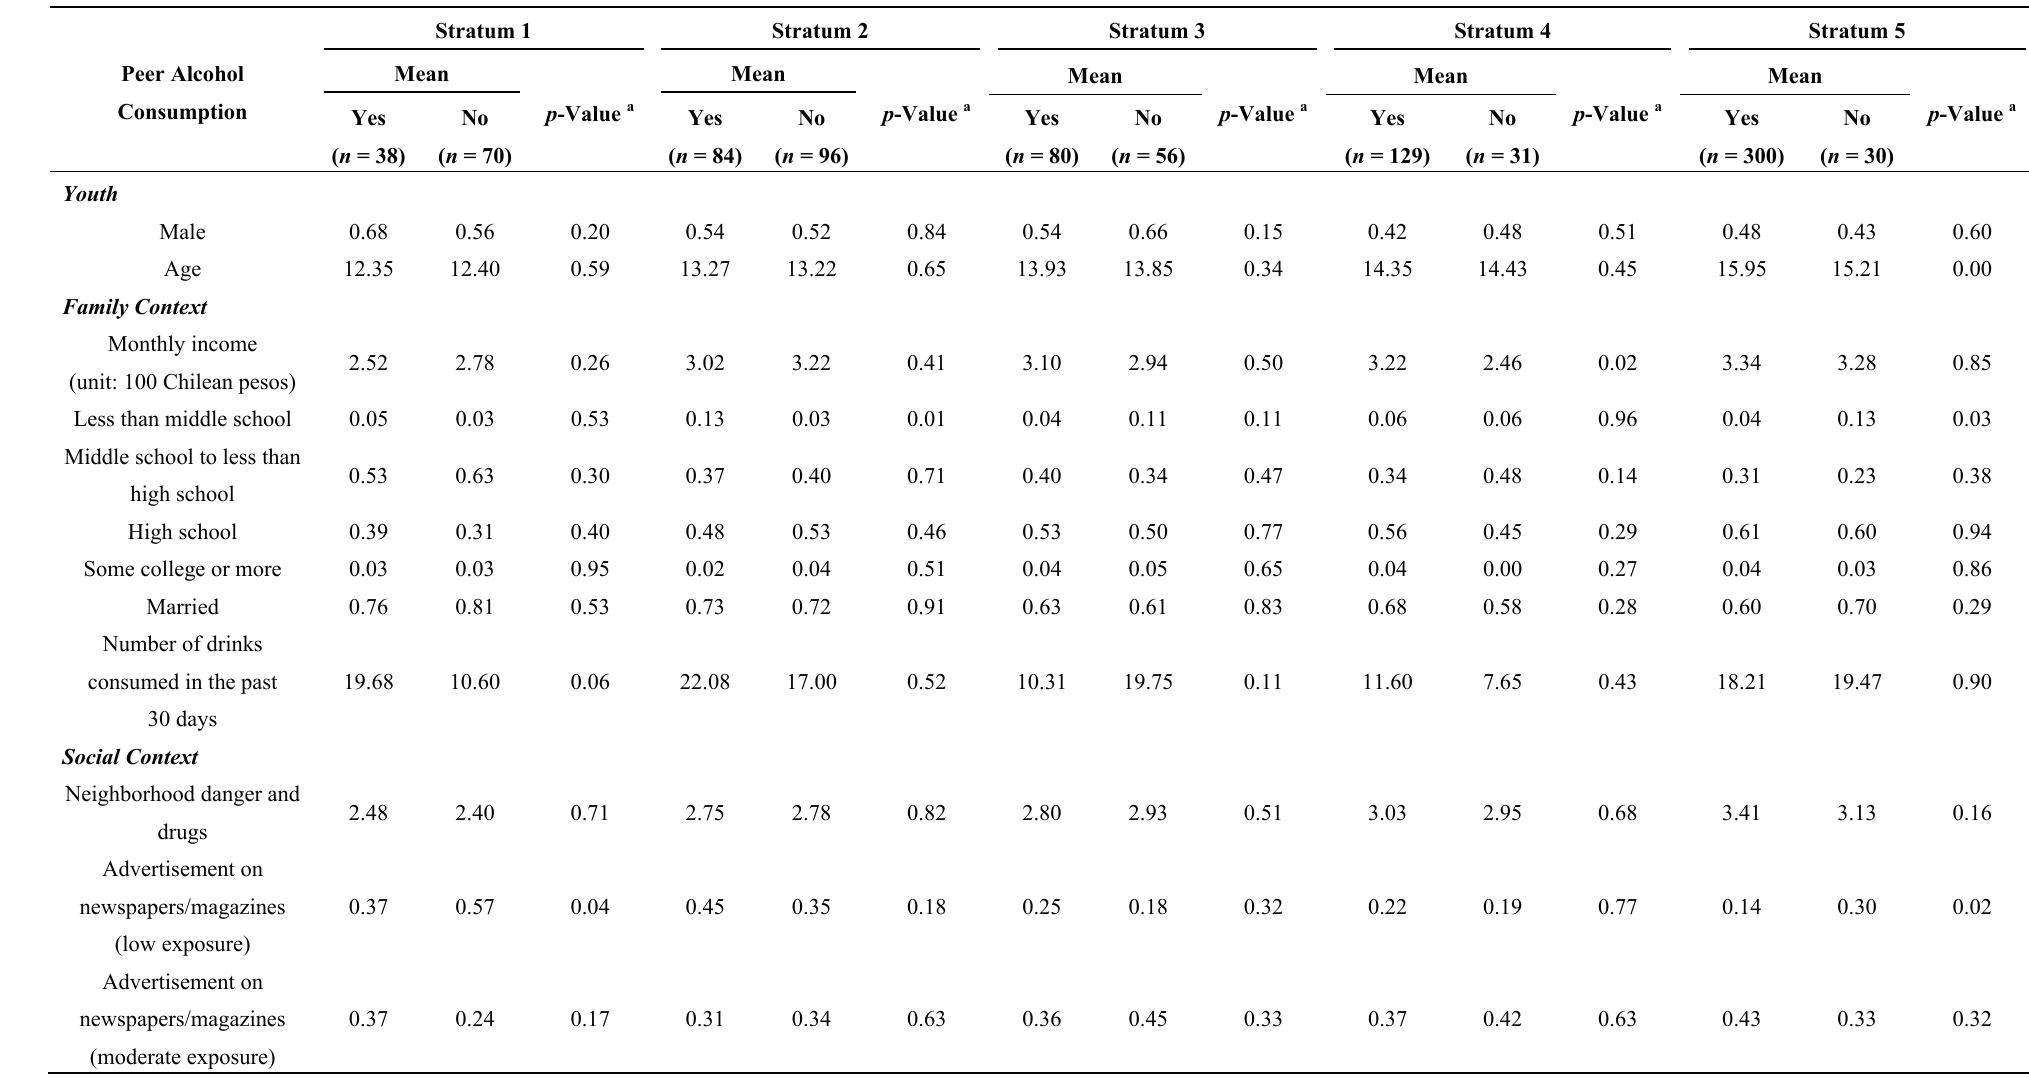
Table 4. Test of Balance across Propensity Score Strata ( N =